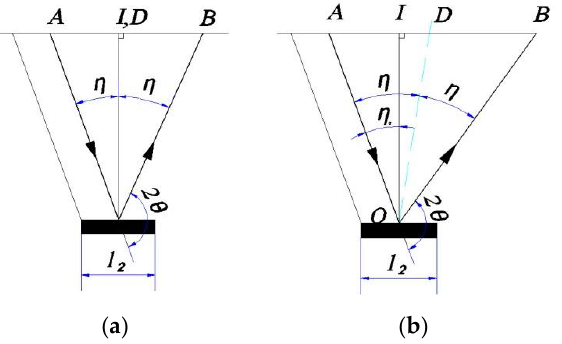
Figure 2. Path length in the side-inclination method. ( a ) Fixed- η method; ( b ) Fixed- η 0 method.